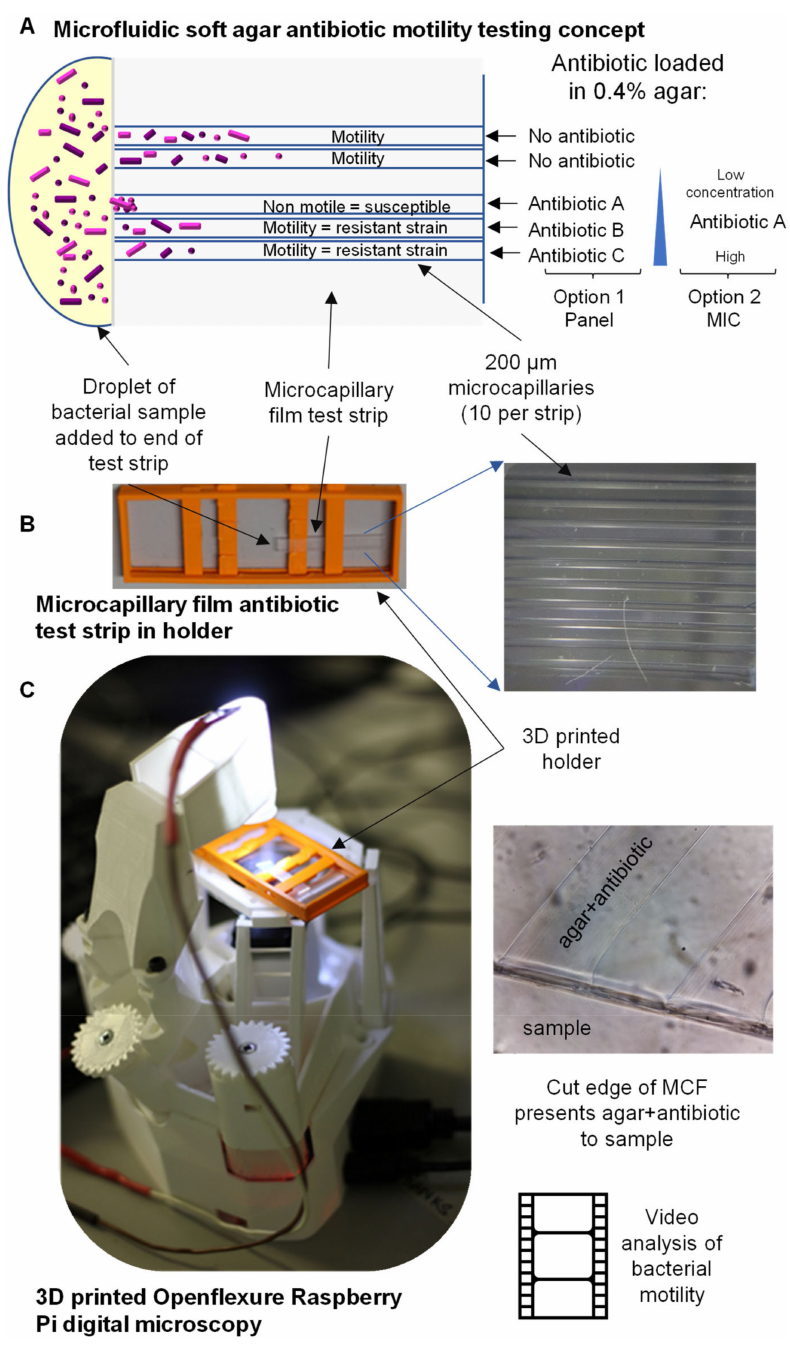
Figure 1. Combining inexpensive microfluidics with 3D-printed digital microscopy to create a simple cytometer for observing response of motile bacteria to antibiotics. ( A ) Schematic of configuration of microcapillary film strip presenting different antibiotics, or different concentrations of a single antibiotic, to a bacterial sample. ( B ) Test strip is contained in simple holder with transparent base; each holder can present four strips each of ten conditions to a single drop of sample. ( C ) Combined with 3D-printed OpenFlexure microscope allows direct observation of how motile bacterial cells response to exposure to